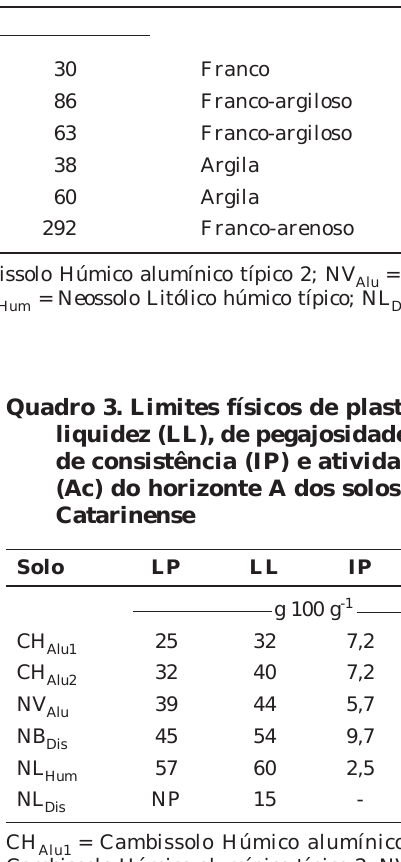
(Dp) do horizonte A dos seis solos do Planalto Sul Catarinense